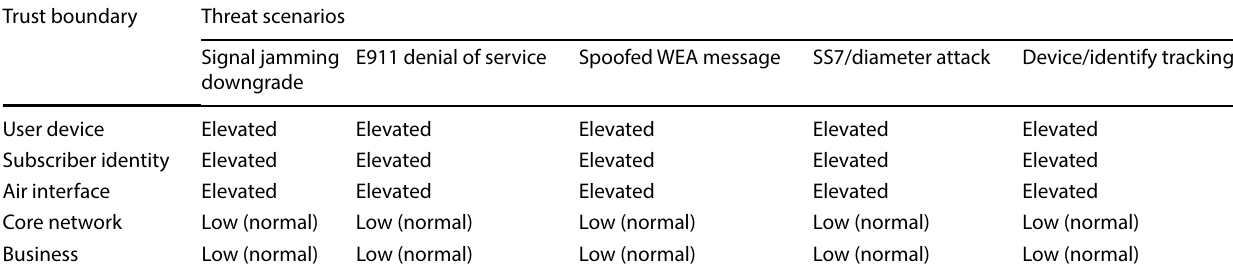
Table 11 Over simplified risk rating Trust boundary